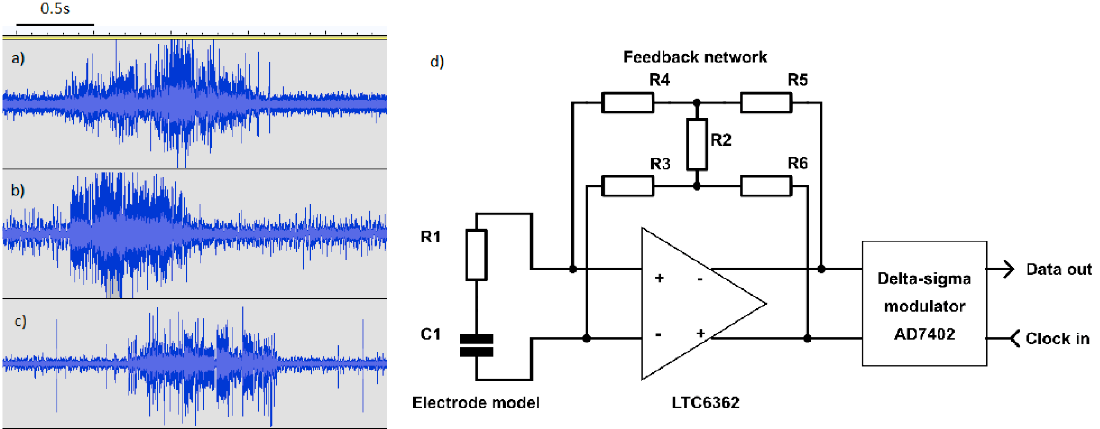
Figure 4. Neural recording from cockroach mechanoreceptors using ( a ) static, single ASIC channel; ( b ) dynamic (scanning 256 channels), ( c ) recording via COTS circuit shown at ( d